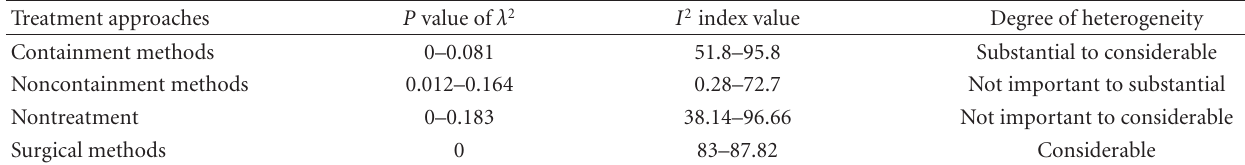
Table 3: Heterogeneity of research